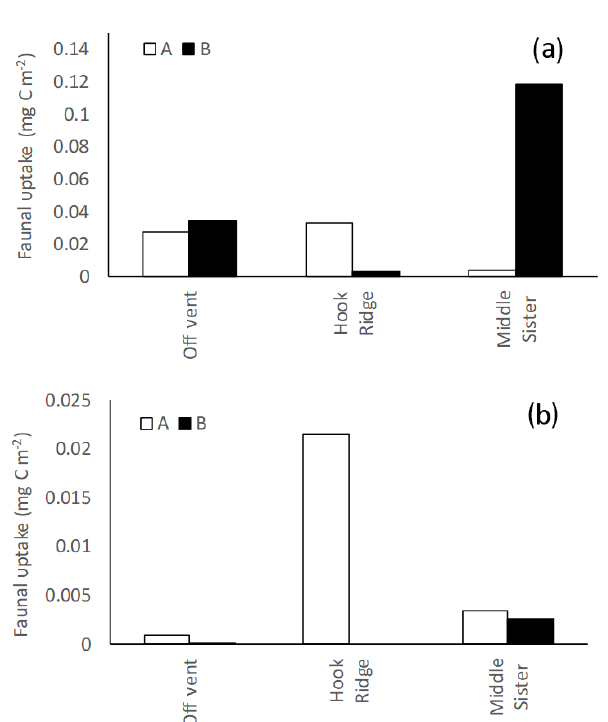
Figure 6. Distribution of C uptake amongst taxonomic groups in the (a) algae addition experiments and (b) bicarbonate addition ex-